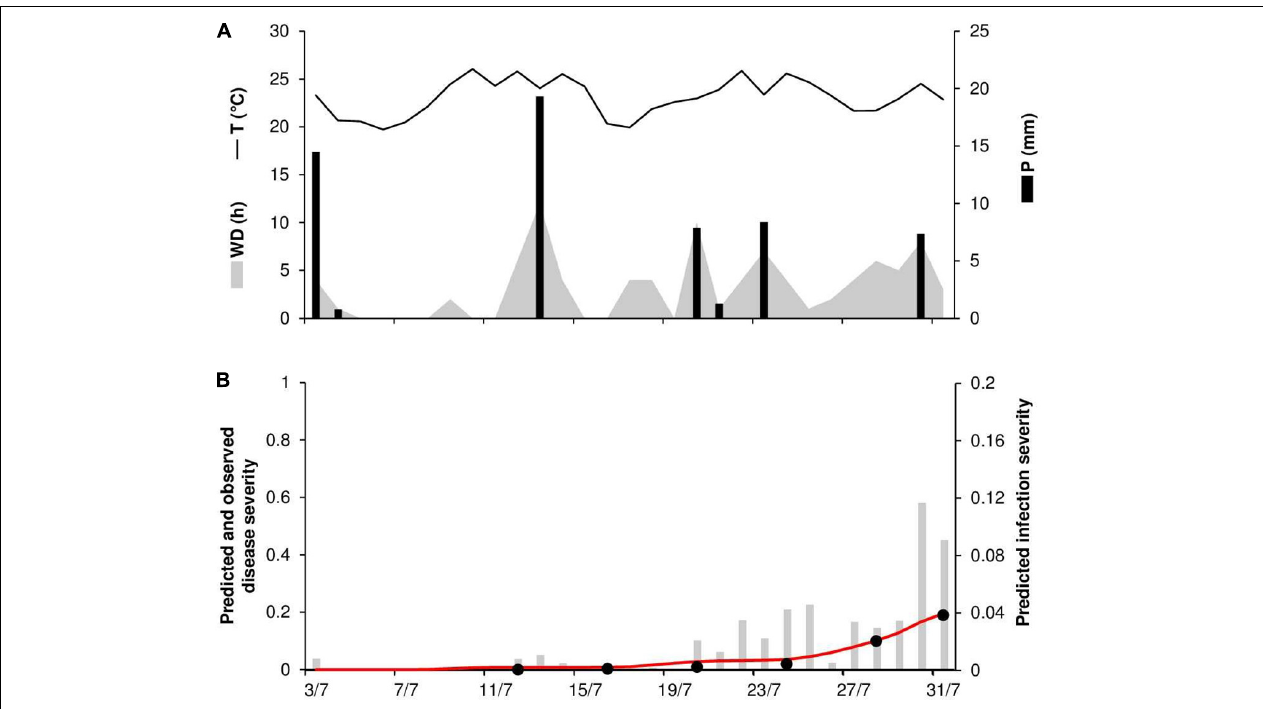
FIGURE 7 | Predicted and observed stem rust progress in the experimental wheat field (susceptible cv. Prelude) in Rosemount, MN, United States, in 1979 (ROS79). (A) Weather variables: air temperature (T, ◦ C, solid line), rainfall (R, mm, black bars), and wetness duration (WD, in h, gray area). (B) Infection severity predicted by the model (gray bars), disease severity predicted by the model (red line), and observed disease severity (full